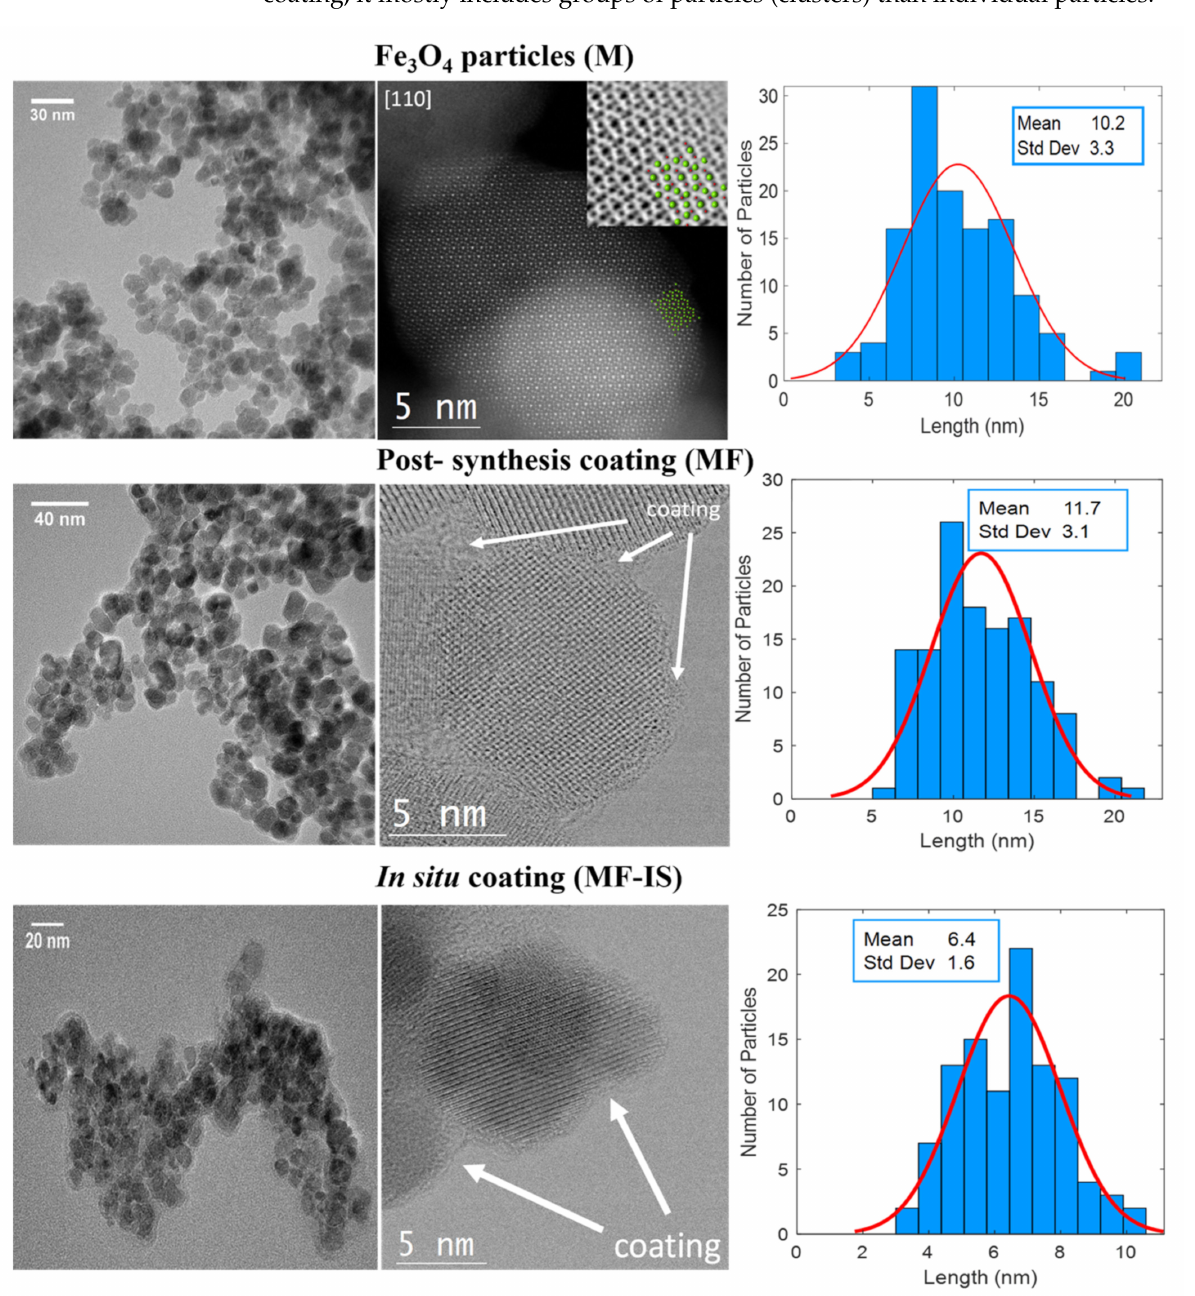
Figure 3. TEM images: low magnification TEM ( left ), Cs-corrected HRSTEM ( center ) and size distributions ( right ) of magnetite (M), post-synthesis fucoidan-coated magnetite (MF), and in situ fucoidan-coated magnetite (MF − IS)